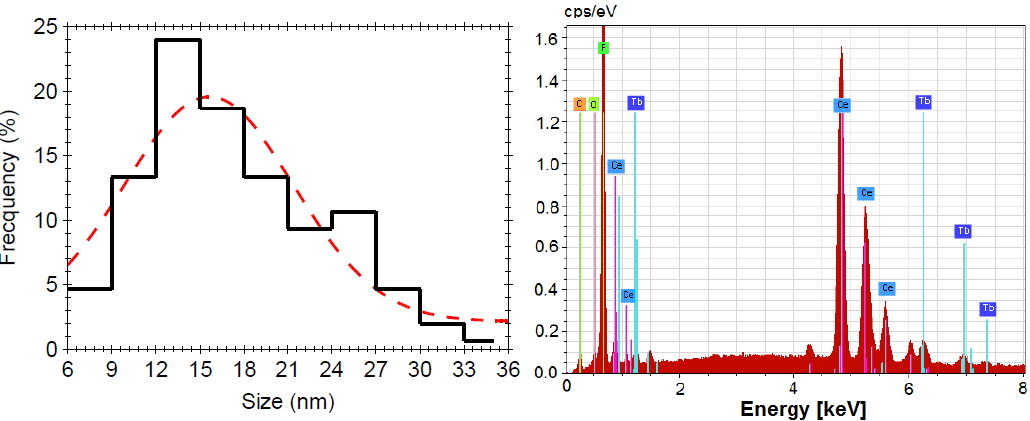
Figure 3. Nanocrystals size distribution ( left ) and the corresponding energy dispersive X-ray (EDX) analysis with the characteristic X-ray lines assignment ( right ); the dotted curve is just a guide for the eyes.